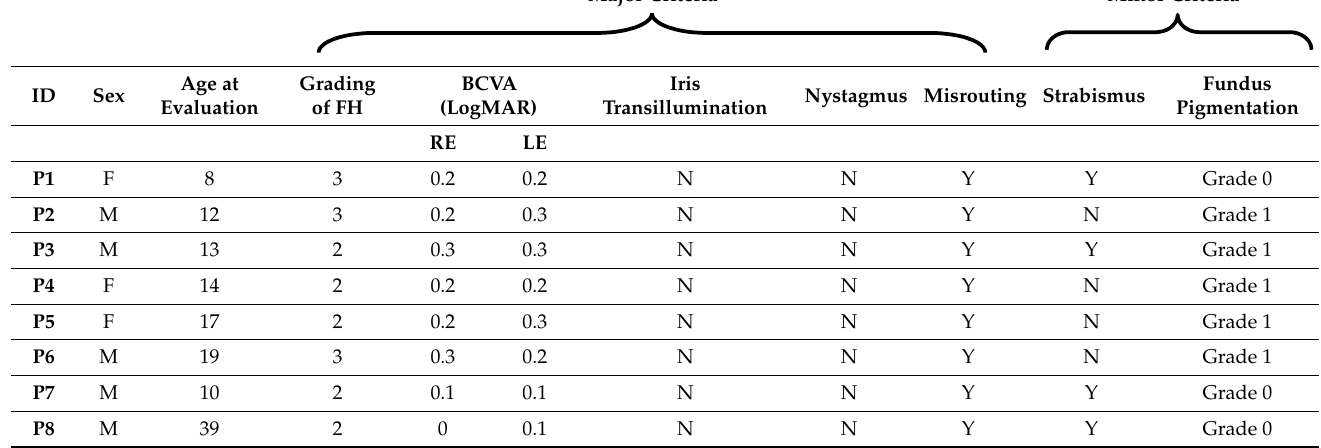
Table 1. Phenotypic data with a clinical distinction between major and minor criteria for albinism.